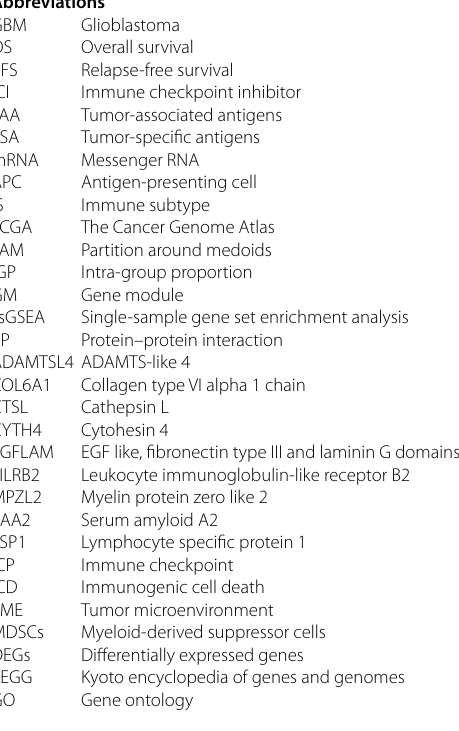
signatures. Figure S7. Identification of functional immune genes modules in GBM. Cumulative distribution function curve ( a ), delta area curve ( b ), and consensus heatmap ( c ) of immune-related gene expression profile in the TCGA cohort. Figure S8. Relationship between GMs and prognosis of GBM patients in the TCGA cohort. Kaplan-Meier curves showing OS analysis of GM1 ( a ), GM3 ( b ), GM4 ( c ), GM5 ( d ), GM6 ( e ) and GM7 ( f ) in the TCGA cohort. Red lines represented high GM scores, blue represented low GM scores. Figure S9. Kaplan-Meier curve showing OS analysis of GM2 in the REMBRANDT cohort. Figure S10. Protein-protein interaction network for GM1 genes. Figure S11. Protein-protein interaction network for GM2 genes. Figure S12. Immune hub genes in GBM. a 51 hub genes in GM1. b The top 10 hub genes in GM2. Figure S13. KEGG pathway analysis of DEGs between responders and non-responders. a KEGG pathway analysis of DEGs in pre-anti-PD-1 treatment samples. b KEGG pathway analysis of DEGs in post-anti-PD-1 treatment samples. Figure S14. Seven candidate antigens detected in the TCGA